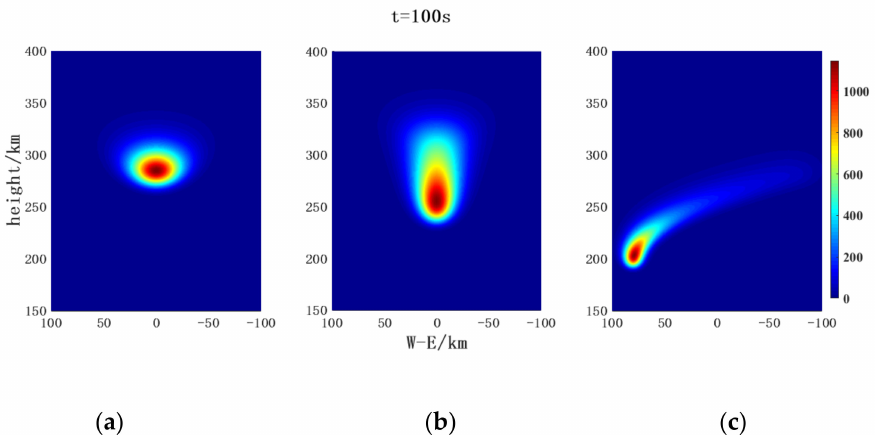
Figure 7. Spatial distribution of H 2 O released by rocket after releasing H 2 O for 100 s under different flight paths; ( a ) 300 km fixed − point release, ( b ) 250 km − 350 km vertical path, ( c ) 250 km − 350 km parabolic path (electron density unit: 10 6 cm − 3